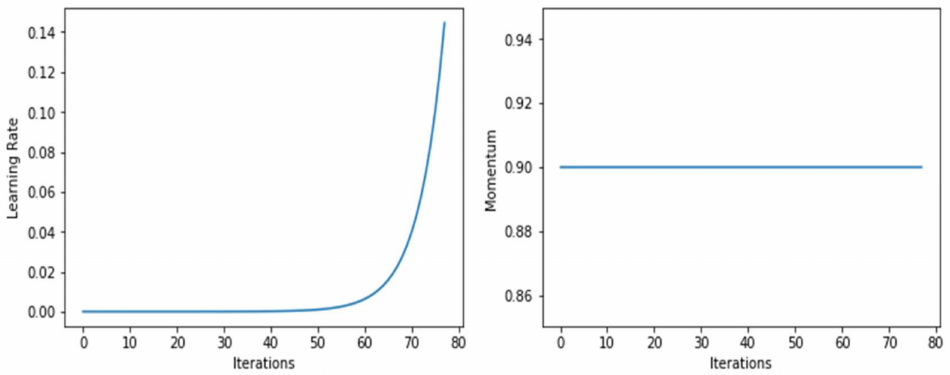
Figure 8. Graphs of learning rate and momentum over iterations before fine-tuning DenseNet-169.